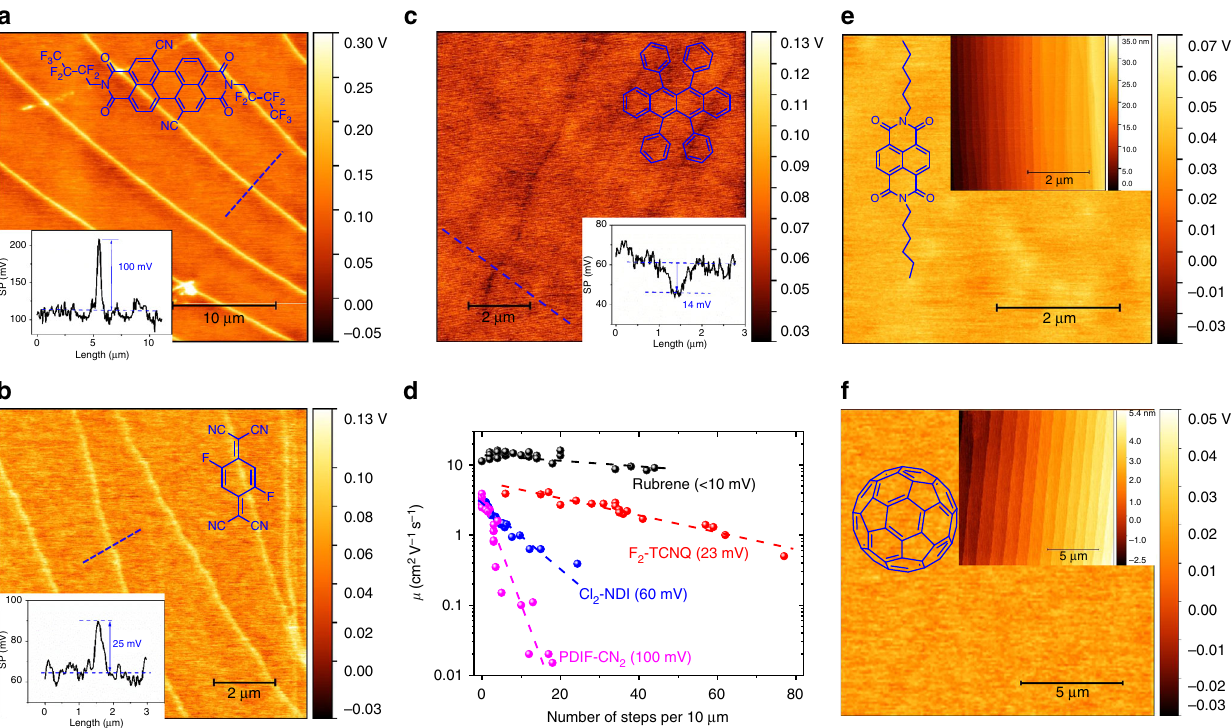
Fig. 5 Surface potential maps of other organic crystals and mobility dependence on step density. SKPM surface potential images of n-type PDIF-CN 2 ( a ), n- type F 2 -TCNQ ( b ), and p-type rubrene ( c ) single crystals. Insets: corresponding molecular structures and surface potential pro fi les along the blue dashed lines for PDIF-CN 2 , F 2 -TCNQ, and rubrene, respectively. Note that step edge potentials for rubrene, a p-type semiconductor, are negative and weak. d Mobility as a function of step density. The black, red, blue, and purple spheres represent rubrene, F 2 -TCNQ, Cl 2 -NDI, and PDIF-CN 2 , respectively. Dashed lines are linear fi ts. The values in parenthesis are average step edge potentials, and it is clear that the slopes of these plots vary systematically with the magnitude of the step edge potential. SKPM surface potential images of n-type C 6 -NDI ( e ) and n-type C 60 ( f ) single crystals show no detectable step edge potentials. Insets show the molecular structures and the corresponding AFM height images revealing large numbers of